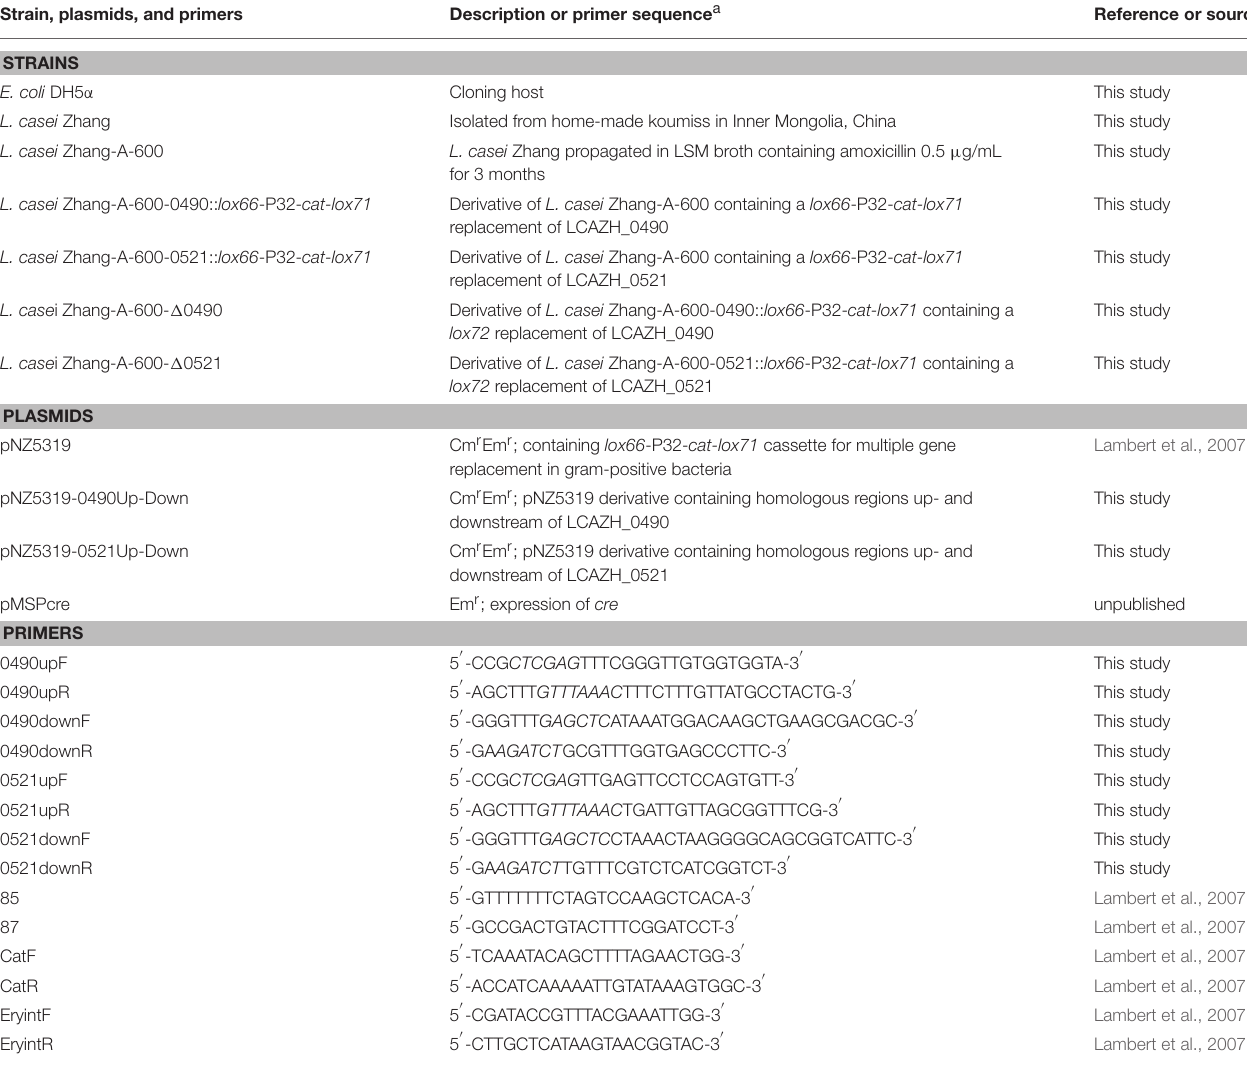
TABLE 1 | Strains, plasmids, and primers used in this